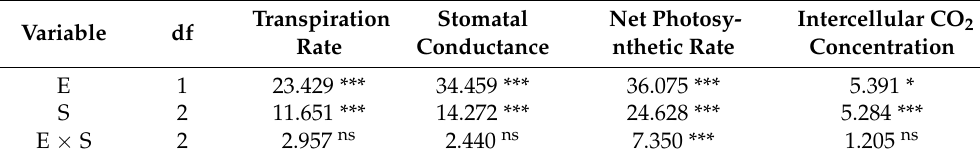
Figure 2. Growth parameters of Hordeum brevisublatum under different concentrations of CdCl 2 stress. ( A ) Plant height, ( B ) Root length, ( C ) Dry weight, ( D ) Fresh weight, ( E ) Tillers numbers, and ( F ) Chlorophyll content. E+: endophyte-infected and E − : endophyte-free. The values presented are mean ± standard error (SE). Lowercase letters (a–d) on top of bars indicate significant differences ( p < 0.05) of E+ and E − plants under the different concentrations of CdCl 2 stress. Table 2. Two-way ANOVA for the effects of endophyte (E) and CdCl 2 stress(S) on photosynthetic parameters of Hordeum brevisublatum